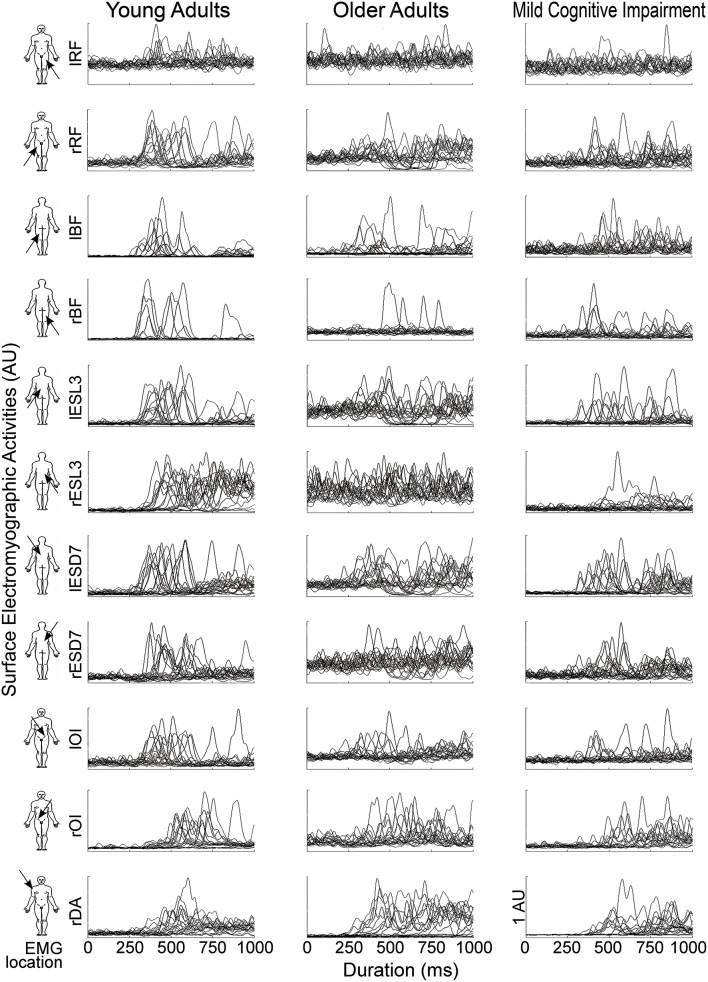
EMG activities of the 11 recorded muscles (line) for one typical participant in each group (column), from left to right: Young Adults (YA); Older Adults(OA); Mild Cognitive Impairment (MCI). Each graph represents the EMG signals of every trials from the illumination of the diode (t = 0) until 1 s. The EMG activities (V) were bandpass filtered between 5 and 400 Hz and then full-wave rectified. For the sake of clarity in this figure, EMG signals were normalized by the maximum EMG value (V) for each muscle and for each participant and were represented in arbitrary units (AU).